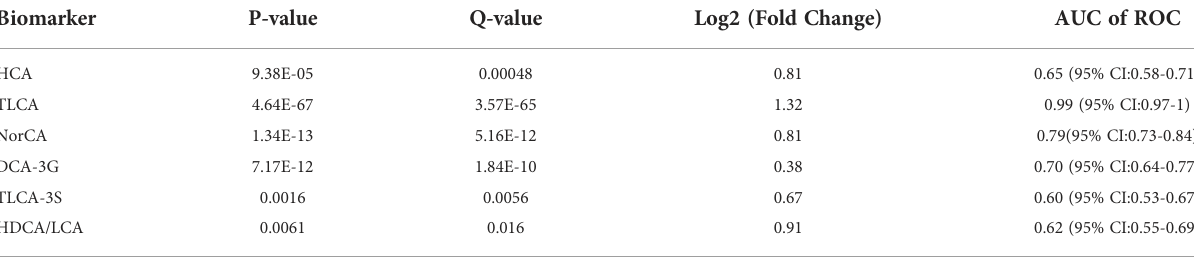
TABLE 2 Characteristics of differential expression of the six markers for GC detection identi fi ed in this study. Biomarker